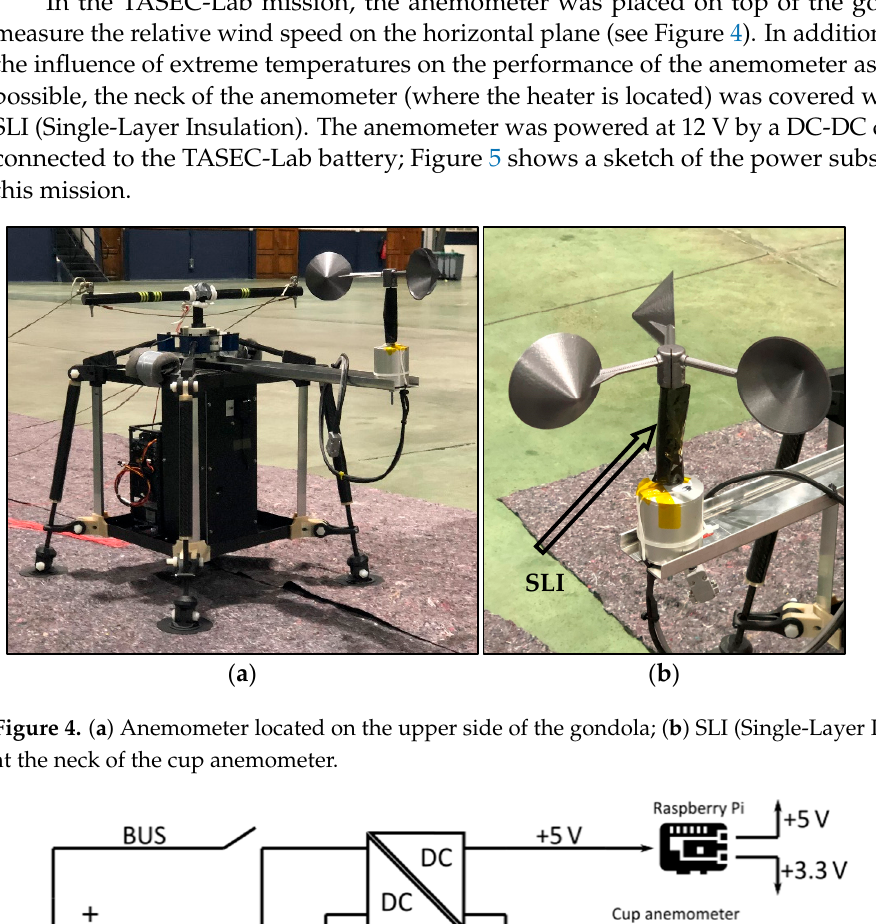
Figure 3. Transfer function (i.e., wind speed, V , vs. output frequency, f ) of the TASEC ‐ Lab cup ane ‐ mometer measured at the LAC ‐ IDR/UPM calibration lab.